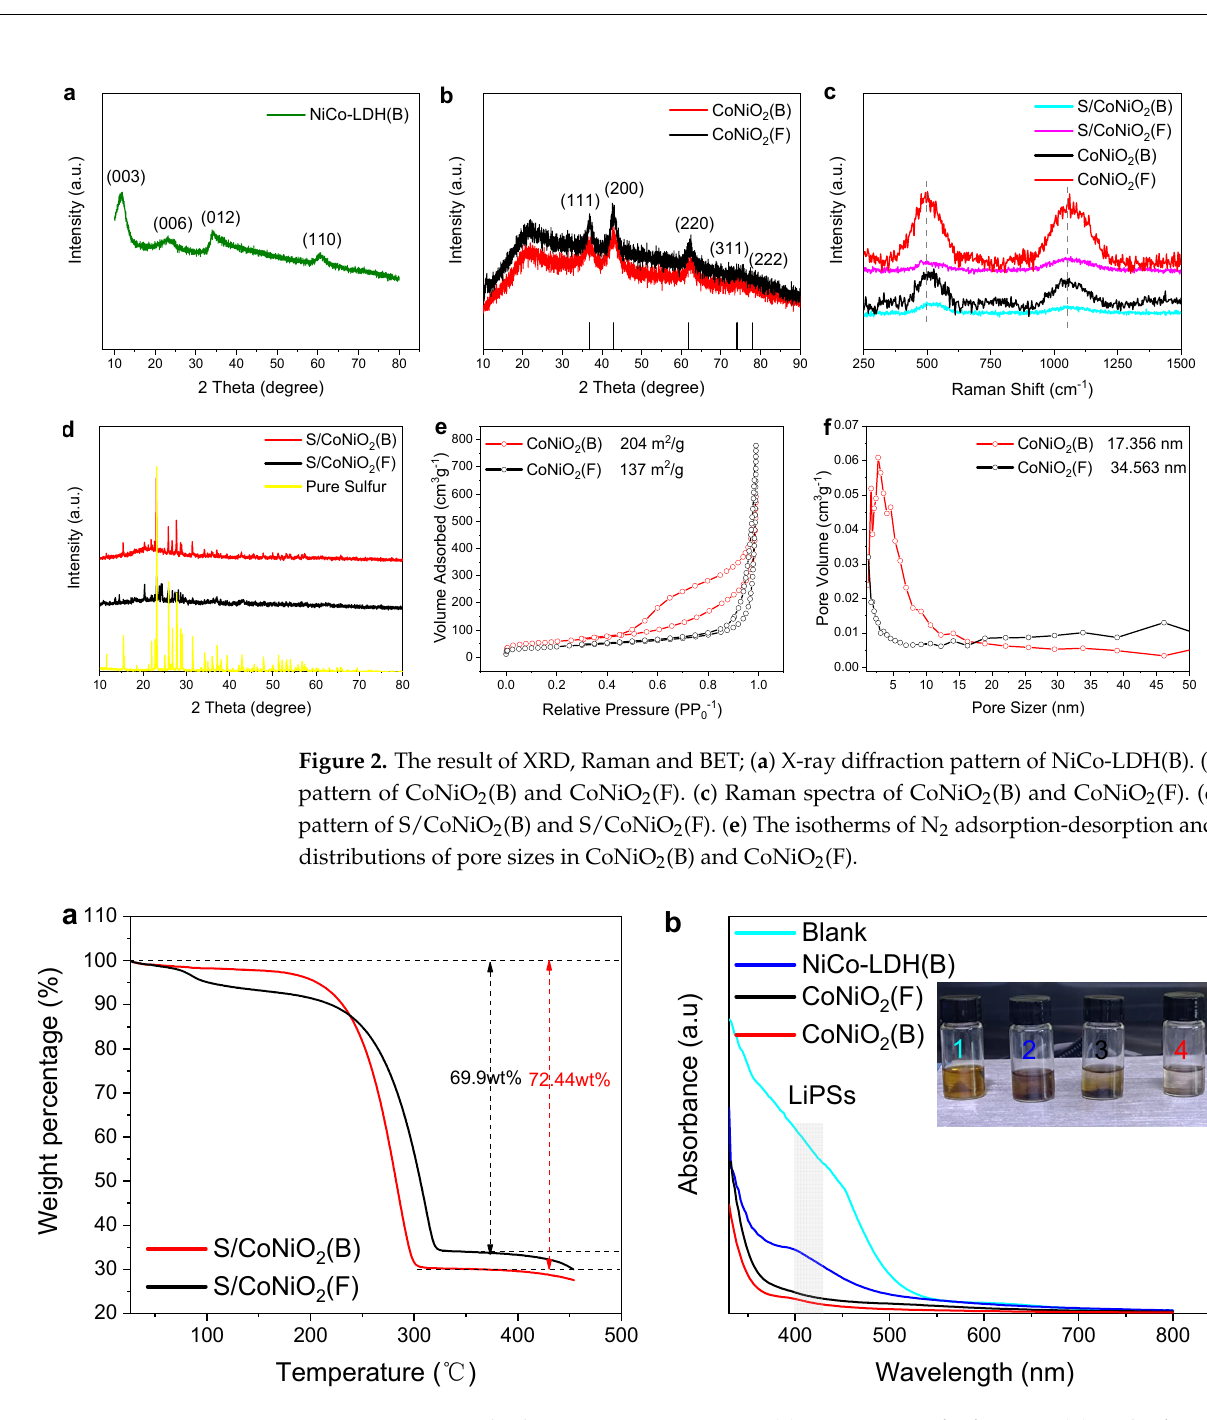
Figure 3. TGA and adsorption measurement; ( a ) TGA curve of S/CoNiO 2 (B) and S/CoNiO 2 (F). ( b ) UV/vis adsorption spectra and static adsorption images.